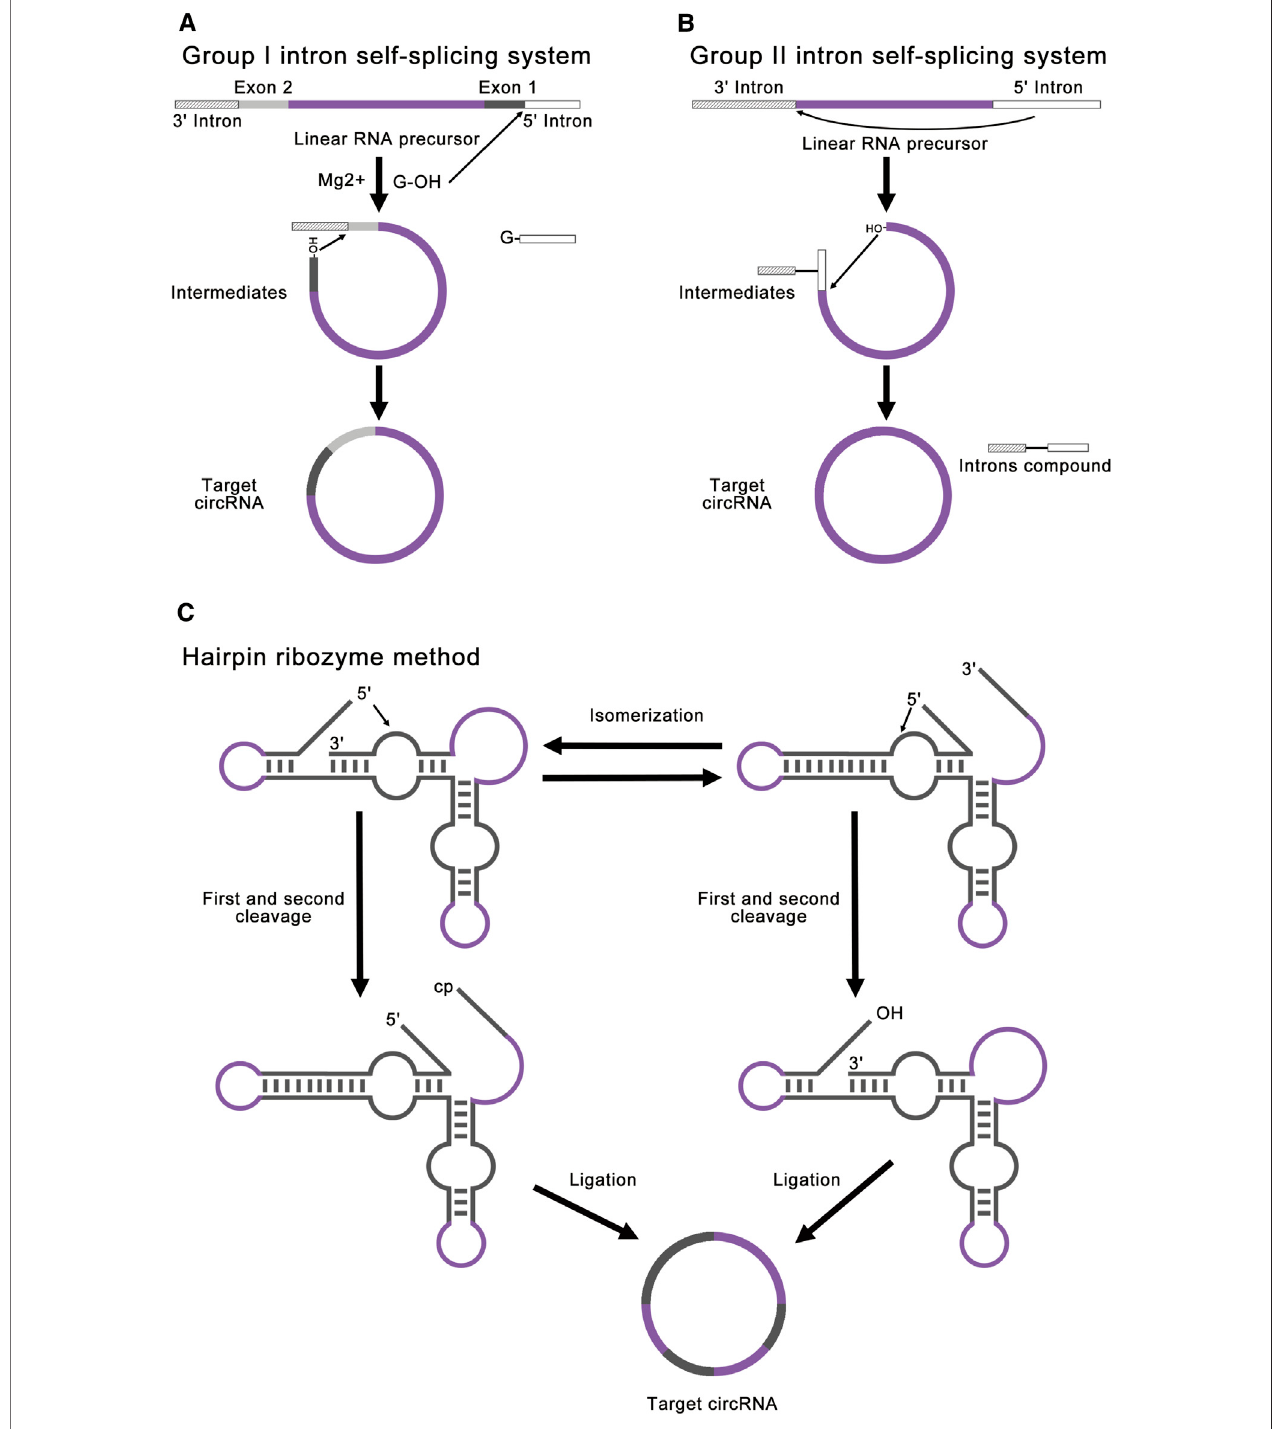
FIGURE 4 | Strategies for ribozyme methods. (A) Group I intron self-splicing system requires only the addition of GTP and Mg 2+ as cofactors and shows great potentialforproteinsynthesis.ThismethodrealizedRNAligationthroughanormalgroupIintronself-splicingreaction,includingtwotransesteri fi cations atde fi nedsplice sites.The fi nalcircRNAwillcontainexogenousexonsequences. (B) GroupIIintronself-splicingsysteminvolvesthejoiningofthe5 ′ splicesiteattheendofanexontothe 3 ′ splice site at the beginning of the same exon. All exon sequences are dispensable for group II intron catalyzed inverse splicing. This method can enable more accuratelinearRNAprecursorligation. (C) HairpinribozymemethodcanproducecircRNAthroughtherollingcirclereactionandtheself-splicingreaction.ThelinearRNA precursorwithHPRwillfoldintotwoalternativecleavage-activeconformationstoremovethe3 ′ -endandthe5 ′ -end.Asaresult,theintermediatewillcontaina5 ′ -OHand a 2 ′ , 3 ′ -cyclic phosphate to produce target circRNA.